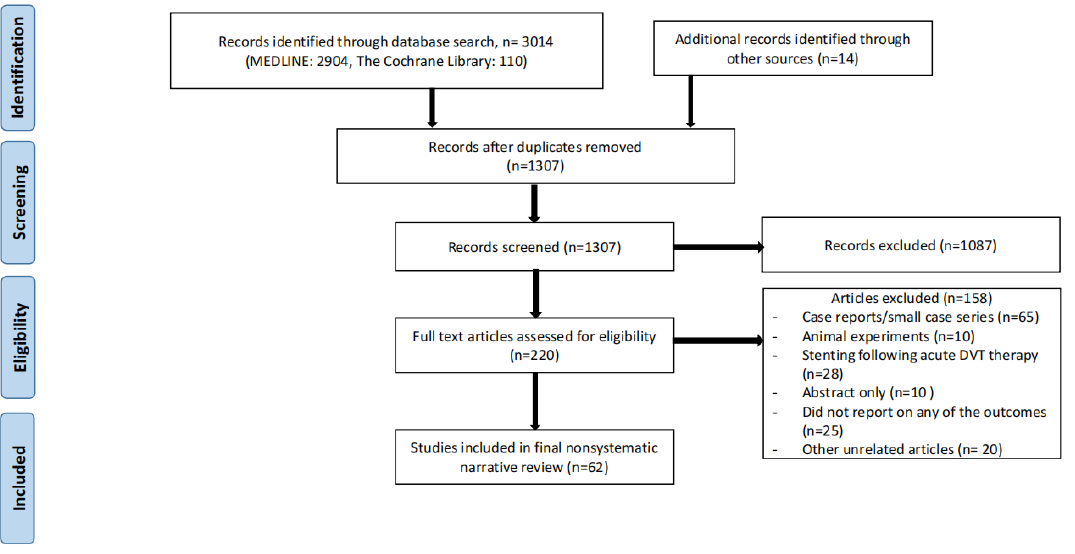
Figure 1. Search strategy for nonsystematic narrative review.